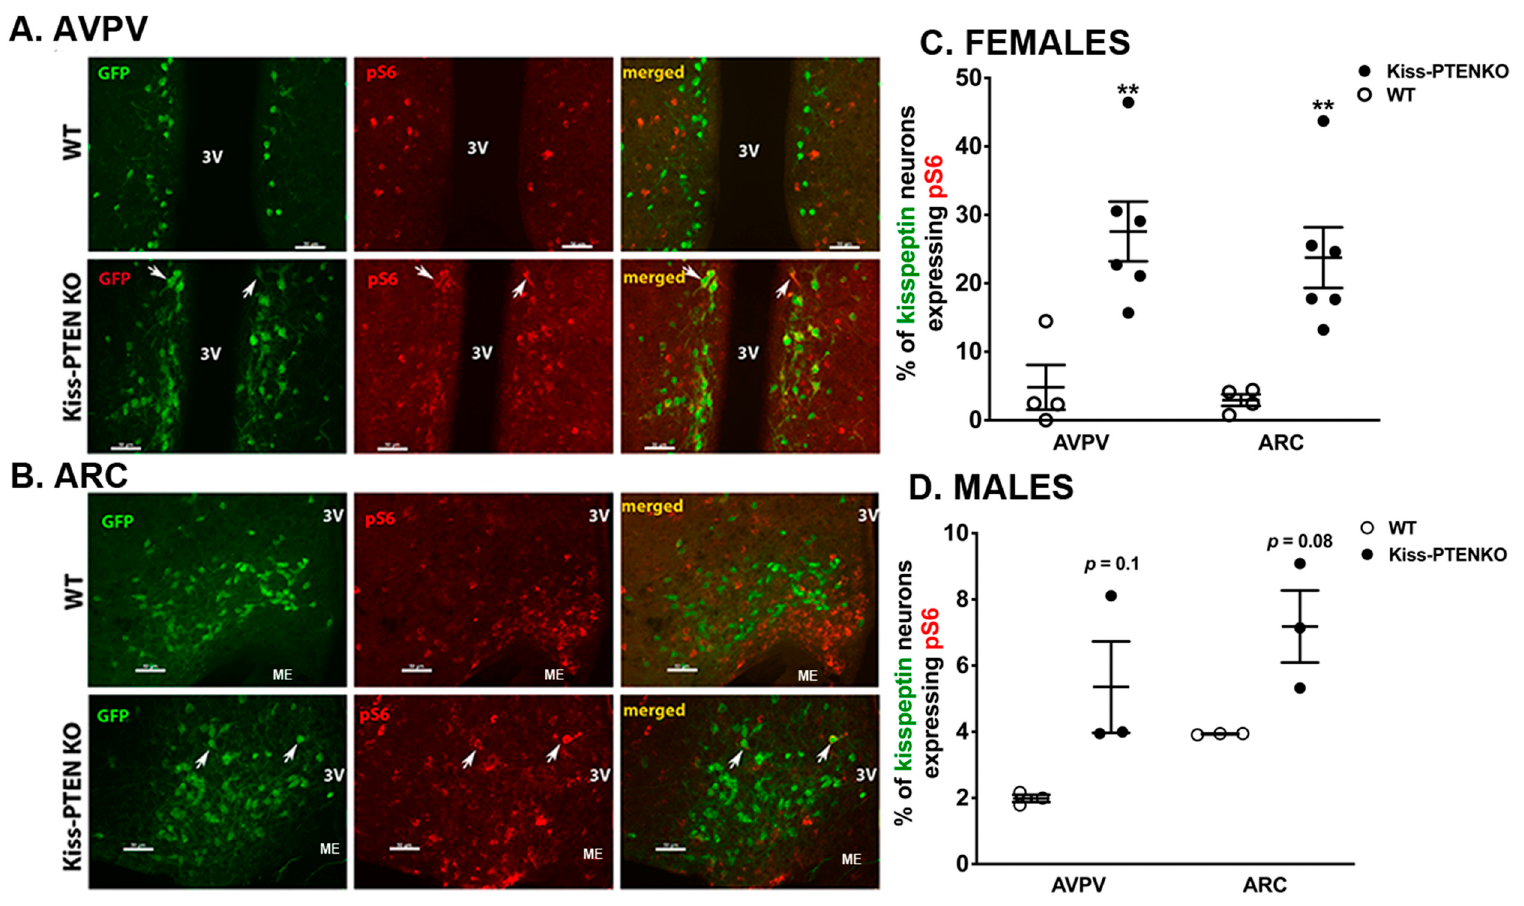
Figure 6. Increased downstream mTOR signaling in female Kiss-PTEN KO AVPV and ARC kisspeptin neurons. Representative fluorescent images of Kiss-GFP + neurons (green), pS6 (red), a marker of mTOR activity, and co-localization (merged, white arrow ) in the AVPV ( A ) and ARC ( B ) of WT and Kiss-PTEN KO / R26-YFP females. Scale bar = 50 µ m. 3V, third ventricle, ME, median eminence. ( C ) Percentage of Kiss-GFP + neurons that co-express pS6 in the female AVPV and ARC ( n = 4–6 / genotype). ( D ) Percentage of Kiss-GFP + neurons that co-express pS6 in the male AVPV and ARC ( n = 3 / genotype). Unpaired t-test, ** p <